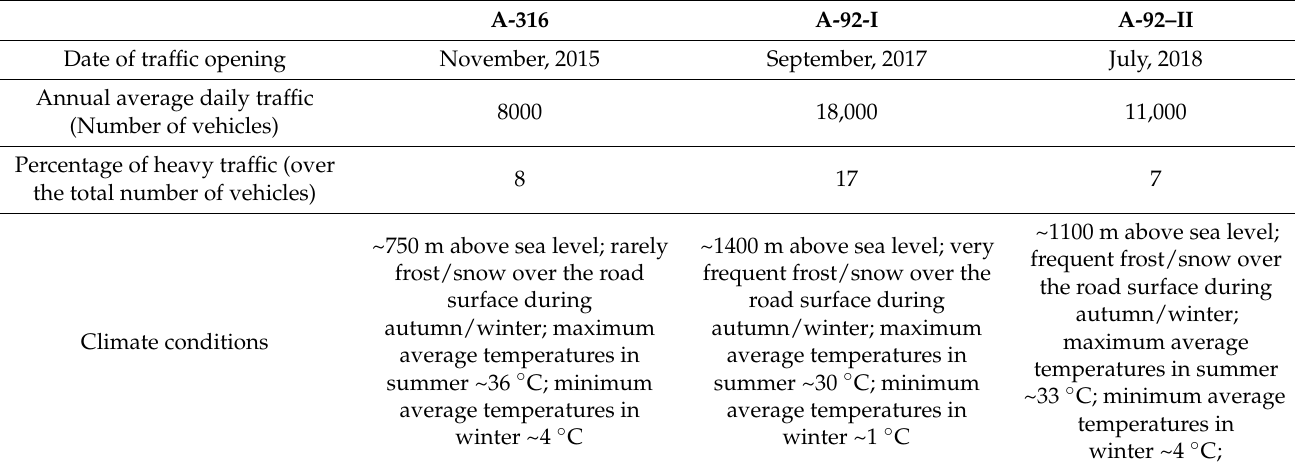
Table 1. Characteristics of the service conditions in the sections